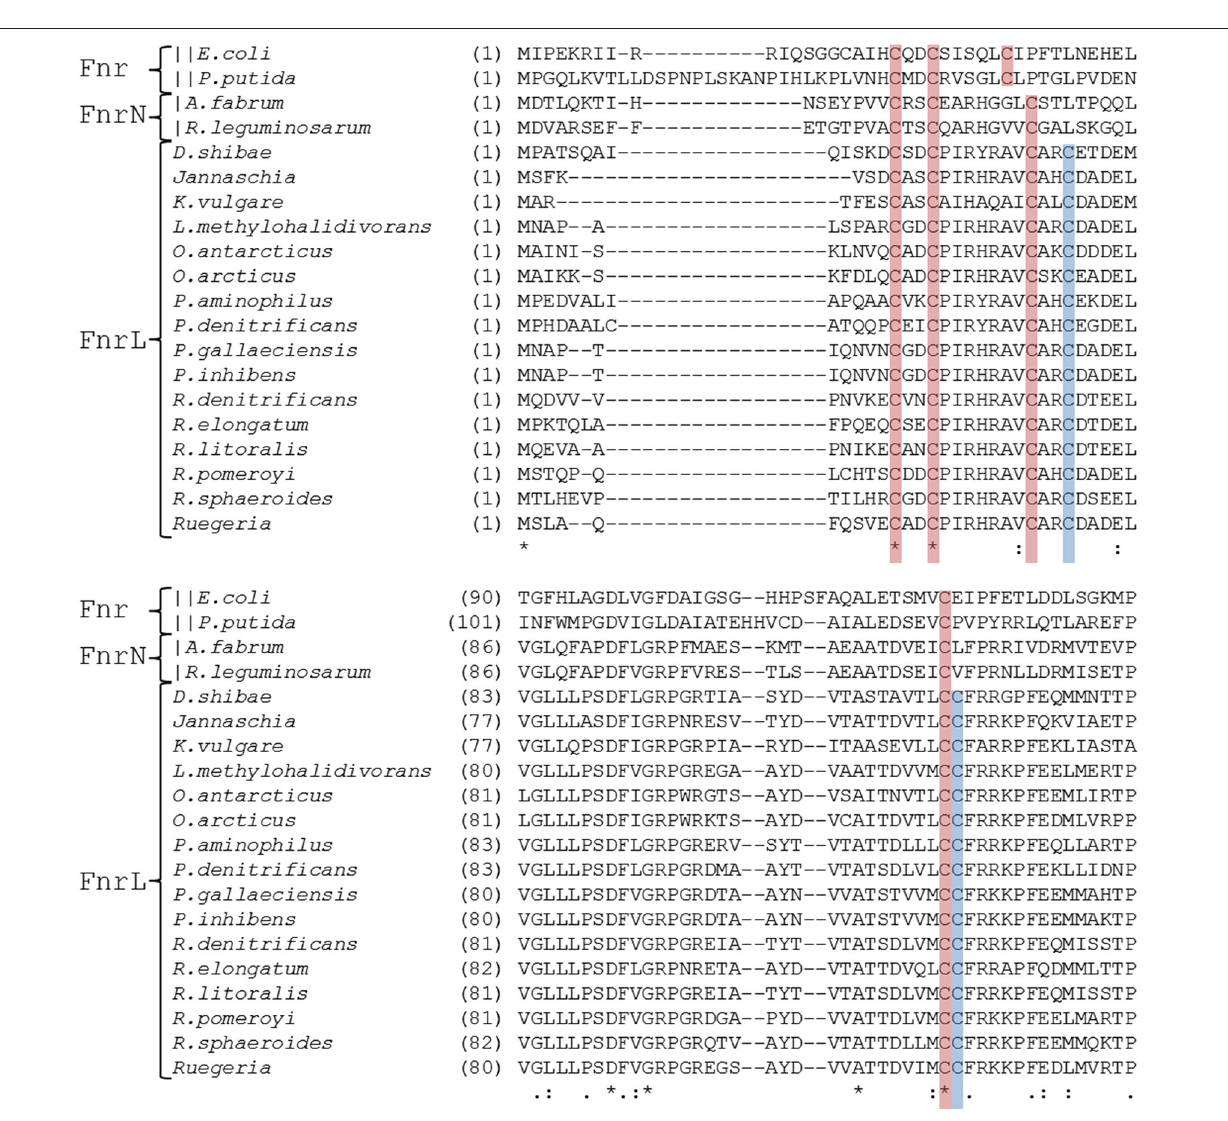
FIGURE 2 | Alignment of the N-terminal regulatory domains of FnrL like regulators. Cysteine residues which were known to be essential for activity in P. denitrificans are marked in red ( Hutchings et al., 2002). Those cysteine residues which were additionally found conserved exclusively in the Roseobacter group are indicated in blue. The alignment comprises the amino acid sequences of FnrL proteins from Dinoroseobacter shibae DFL12 T (WP_012177338.1), Paracoccus denitrificans (WP_041529894.1), Rhodobacter sphaeroides (WP_002720880.1), Roseobacter litoralis (WP_044025718.1), Roseobacter denitrificans (WP_044032974.1), Pheobacter gallaeciensis (WP_014881157.1), Phaeobacter. inhibens (WP_040174583.1), Roseibacterium elongatum (WP_025310970.1), Ruegeria pomeroyi (WP_011049211.1), Leisingera methylohalidivorans (WP_024088845.1), Ruegeria sp. (WP_039983362.1), Jannaschia sp. (WP_011456972.1), Paracoccus aminophilus (WP_020949853.1), Octadecabacter antarcticus (WP_015498258.1), Octadecabacter arcticus 238 (WP_015493613.1), Ketoglonicigernium vulgare (WP_013383280.1). In addition, Fnr from Escherichia coli (WP_000611911.1) and Anr from Pseudomonas putida (WP_010954166.1) were included. Symbols indicates an entirely conserved column (*), a column comprising amino acids of same size and hydropathy (:) and a column comprising amino acids of similar size or evolutionary preserved hydropathy (.) (Notredame et al.,